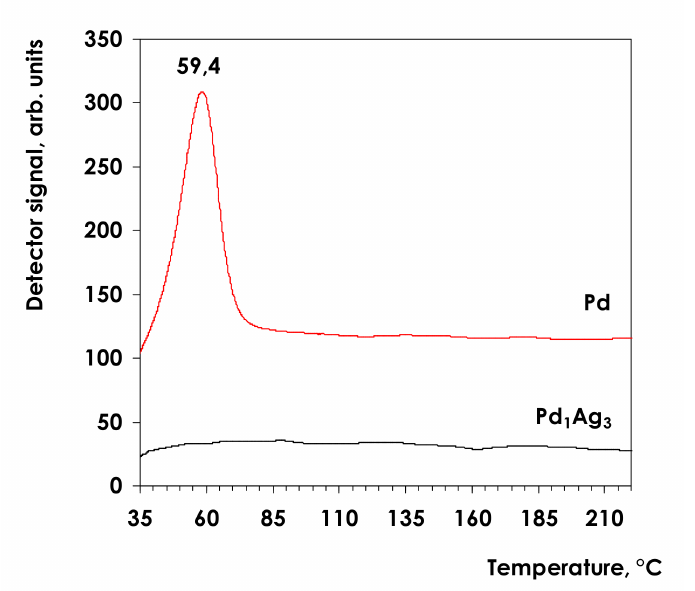
Figure 1. Temperature-programmed Pd hydride decomposition profiles for the monometallic Pd and Pd 1 Ag 3 SAA catalysts.